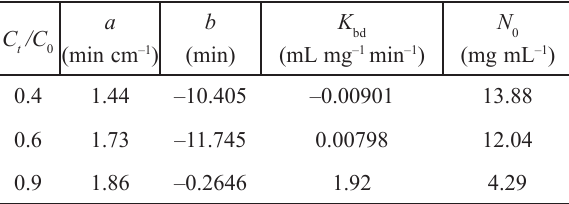
Table 5 – Packed bed parameters for different models for the adsorption of acrylic acid onto CaO Exp.